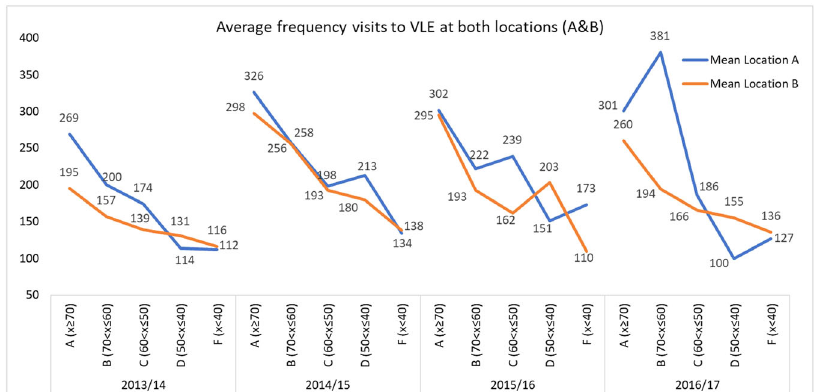
Fig. 4 Engagement VLE and assessment outcome (2013 – 2017). Results from an analysis of average learner engagement with VLE as related to assessment achievement.